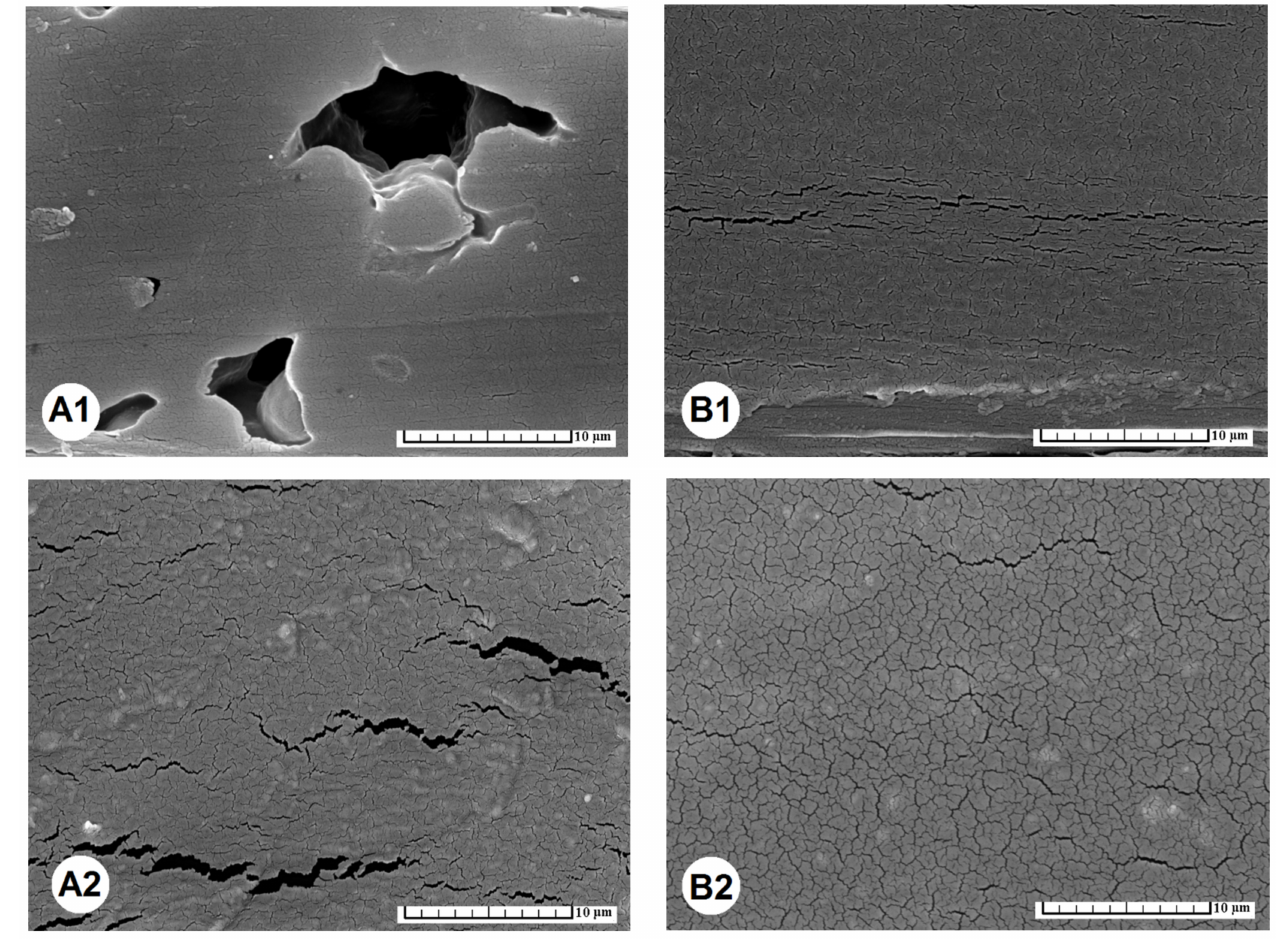
Figure 6. Morphology of the structure of glued joints using PUR ( A1 , A2 ) and PVAc ( B1 , B2 ) glues for bonding the TM spruce wood prepared at 220 ◦ C. In the PUR glue typical micro-bubbles were formed and seen in the longitudinal cut ( A1 ), while in the cross-section cut exceeding fragility of the glue layer occurred ( A2 ). A seemingly smooth line of a joint created from PVAc glue shows fragility when enlarging by 8000 × in the case of longitudinal cut ( B1 ) as well as cross-section cut ( B2 ), and it is finer in comparison to PUR glue. Scale bar = 10 µ